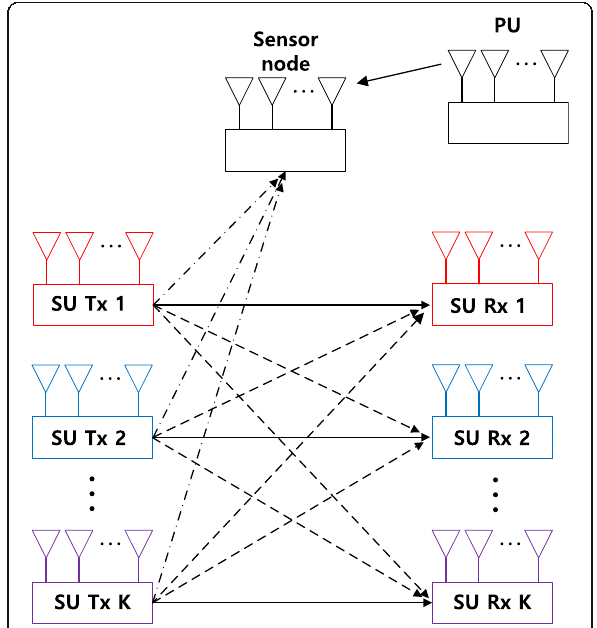
Fig. 2 Proposed system with interference alignment in CR system. The sensor node can sense the PU by using interference alignment even while the SUs are transmitting data use, and it will notify whether or not to transmit to the SUs depending on whether or not the PU is